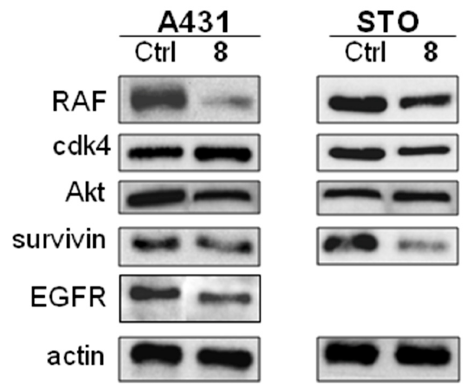
Figure 5. Analysis of HSP90 client protein levels in A431 and STO cells after 24 h of treatment with compound 8 (2.6 μ M in A431 cells; 2.6 μ M in STO cells). Total cellular extracts were obtained 24 h after cell treatment Actin is shown as a control for protein loading.